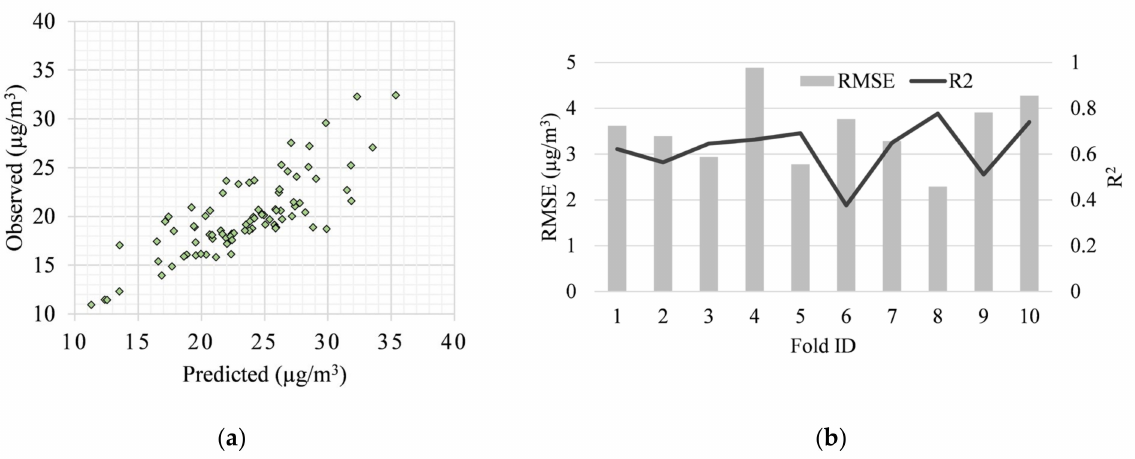
Figure 12. External verification using the PM 2.5 data of the year 2018. ( a ) Observed ( y -axis) and estimated ( x -axis) PM 2.5 concentration from Model B. ( b ) Accuracy assessment using tenfold cross- validation scheme.